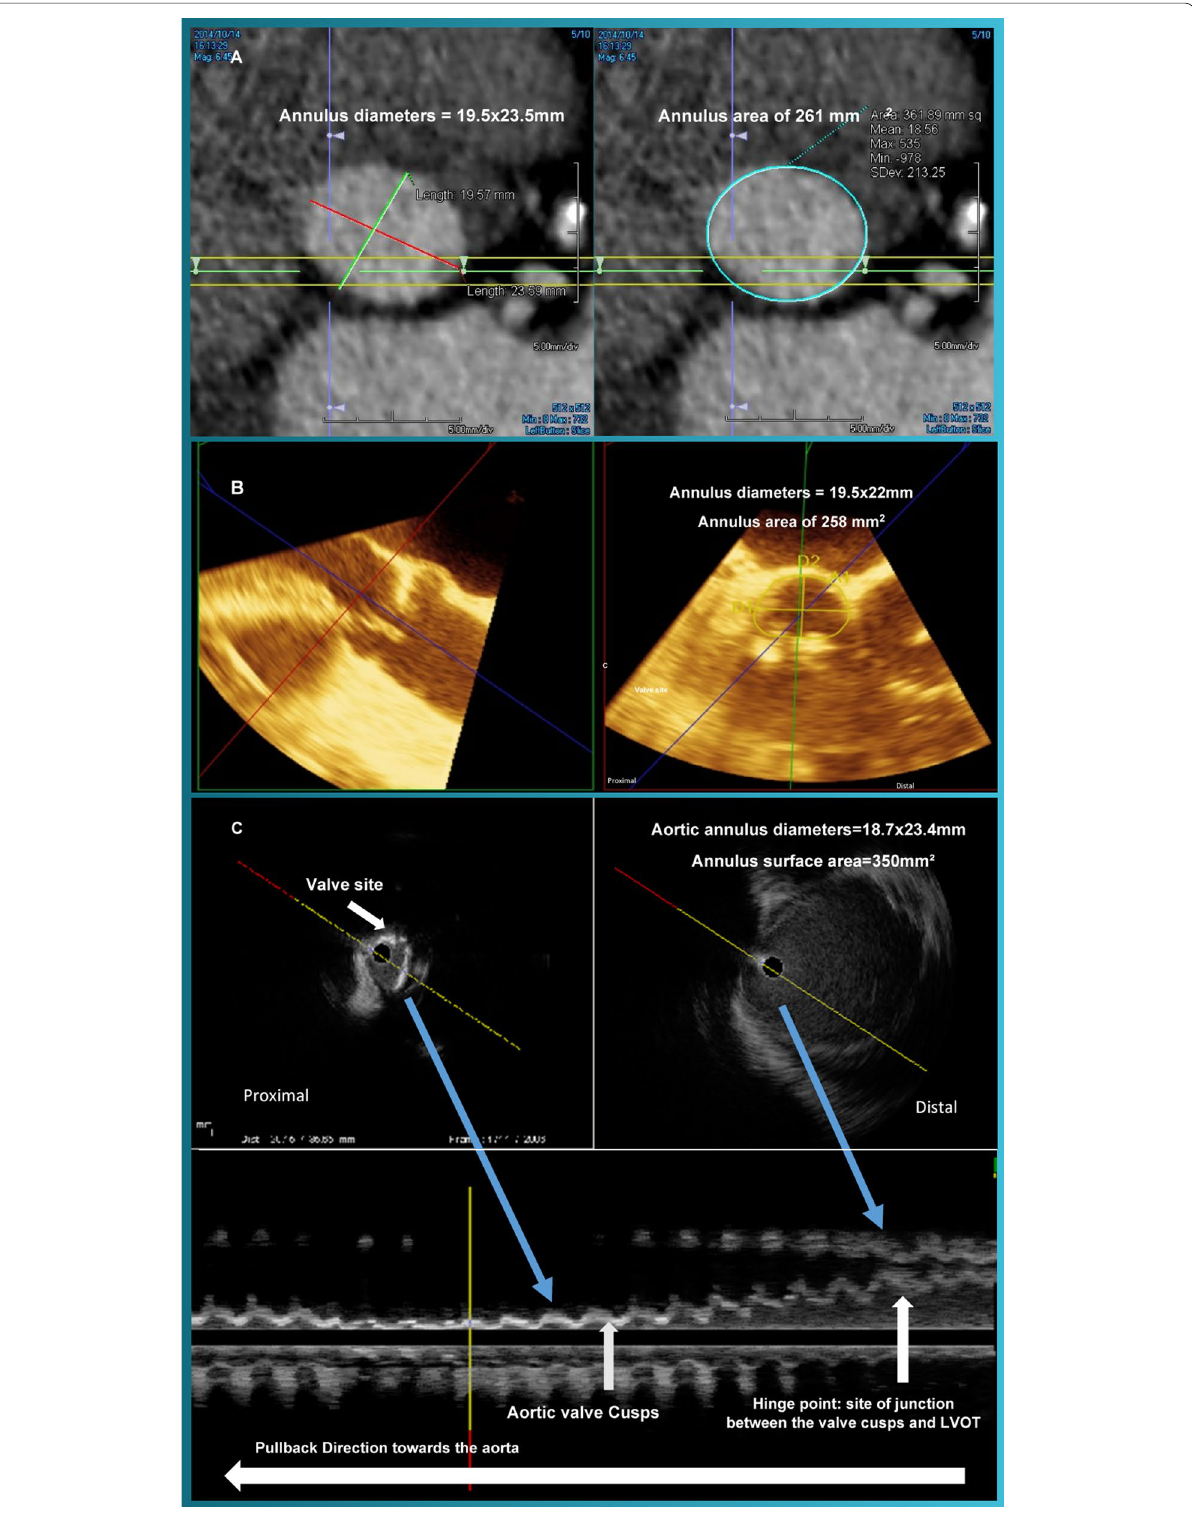
Fig. 2 Comparative measurements of the aortic valve annulus obtained by MDCT, 3D TEE and far field IVUS. Panel A MDCT measurements of the aortic valve annulus; Panel B 2D TEE measurements of the aortic valve annulus; Panel C far field IVUS measurements of the aortic valve